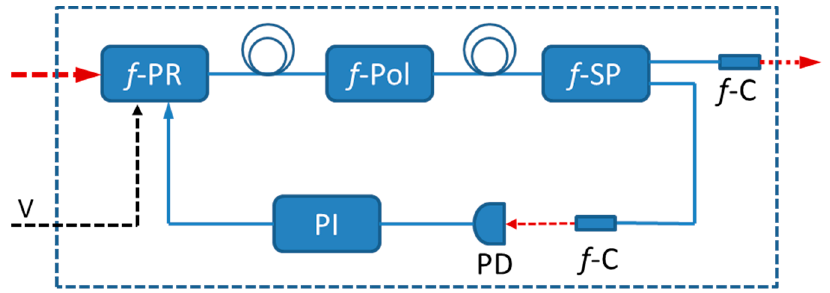
Figure 1. Schematic diagram of the intensity-stabilization of a distributed feedback (DFB) laser; f -PR: fiber polarization rotator; f -Pol: fiber polarization; f -SP: fiber splitter; f -C; fiber coupler; PD: photodiode; PI: proportion- integration controller. The f -PR and f -Pol make jointly up the intensity controller (IC).